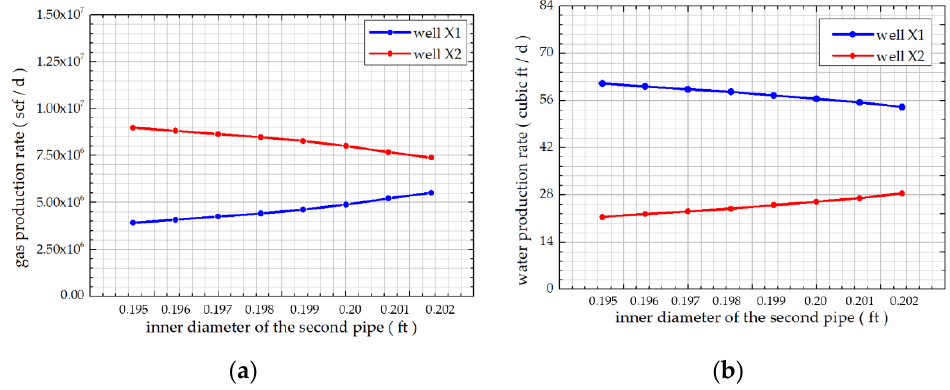
Figure 15. Calculation results under different inner diameter of pipes: ( a ) gas production rate; ( b ) water production rate.